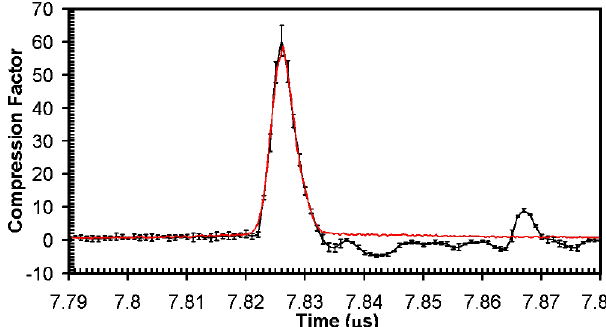
FIG. 7. (Color) Fast Faraday cup measurement of longitudinal current compression: (black) experiment; (red) LSP